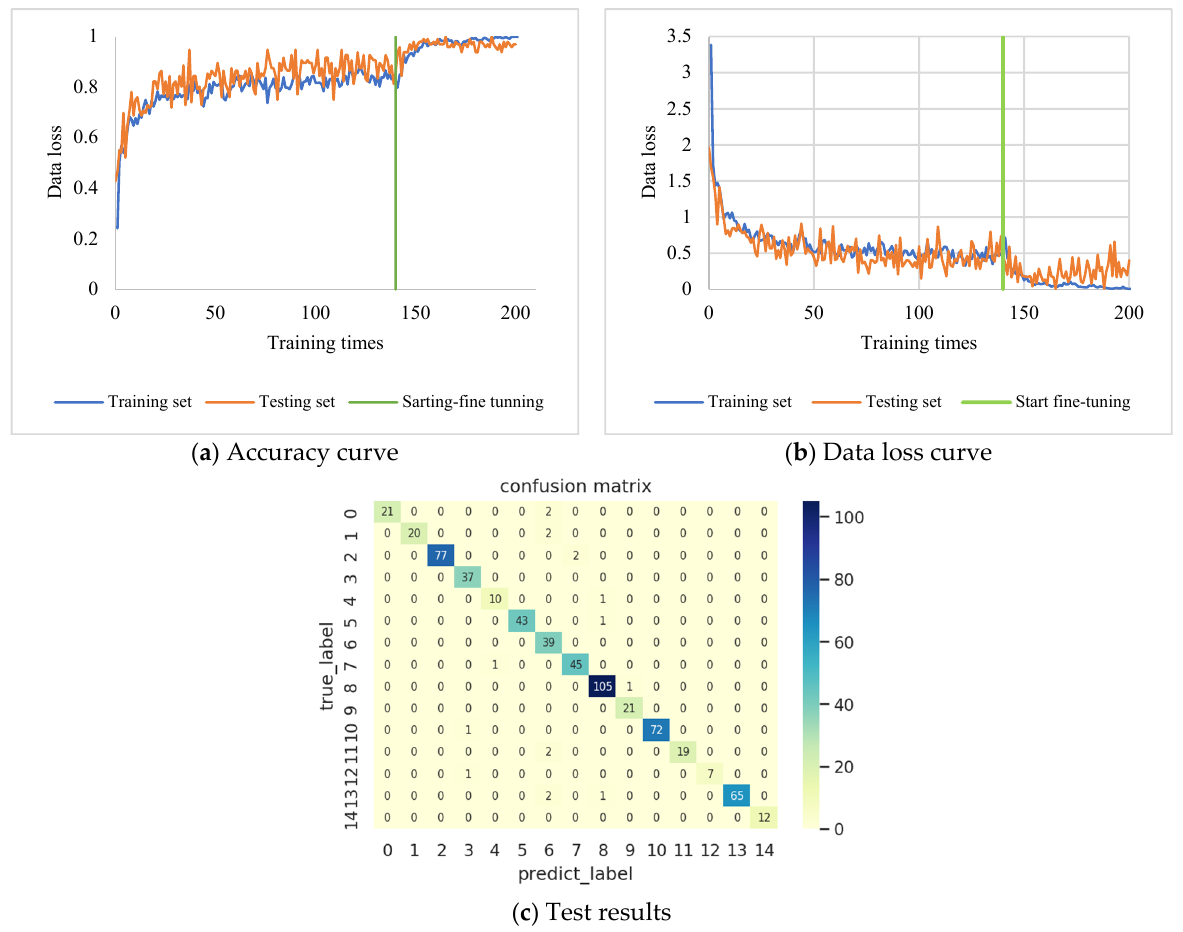
Figure 6. Densely connected model applying global pooling layer classifier.